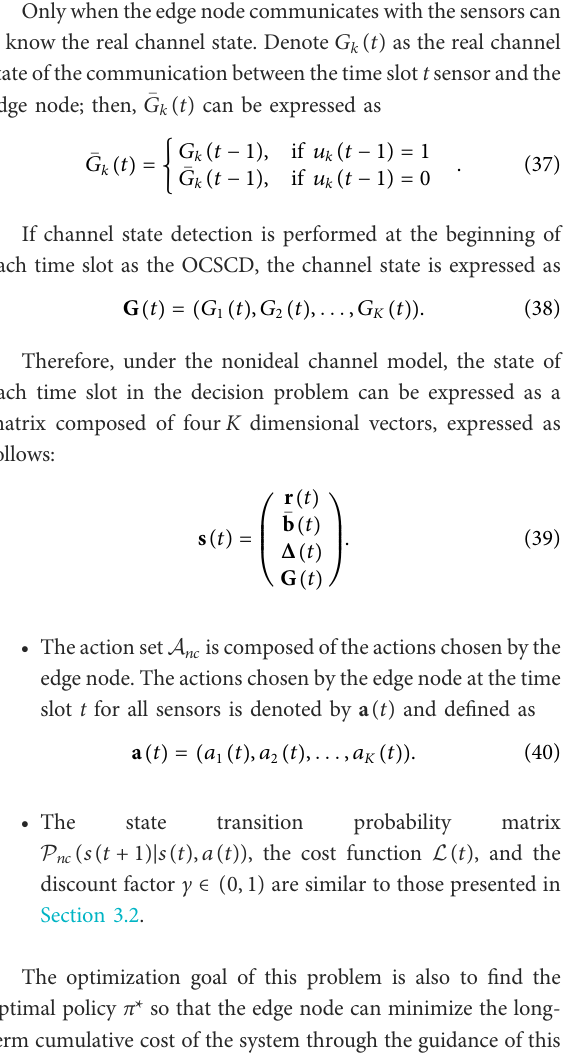
Algorithm 2. Obtaining the optimal policy based on